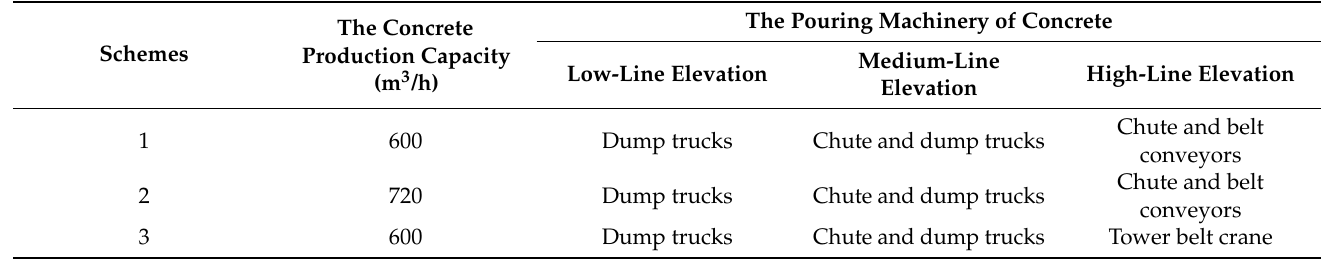
Table 6. Construction resource investment of the RCC gravity dam construction